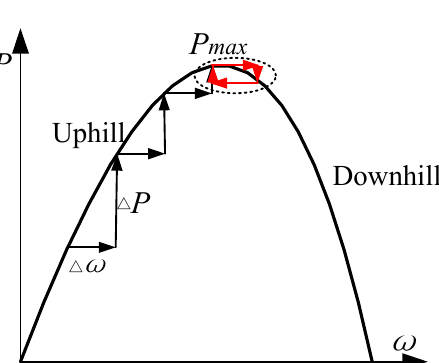
Figure 5. HCS control